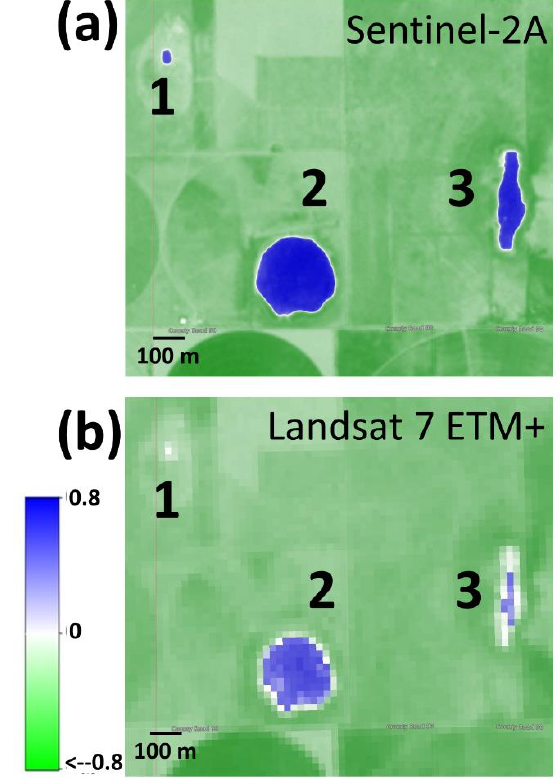
Figure 2. ( a ). Sentinel-2A imagery of the Normalized Difference Water Index (NDWI) for the location denoted with a yellow dot in Figure 1 on 22 September 2021, and ( b ) Landsat 7 ETM+ NDWI imagery from the same location on 19 September 2021. Blue areas represent water, while green areas indicate non-water areas. The 3 playas referenced in the text are indicated by the numbers 1 – 3. NDWI is processed by Sentinel Hub. The imagery contains modified European Space Agency Copernicus Sentinel data processed by Sentinel Hub, and Landsat 7 images are courtesy of the U.S. Geological Survey, processed by Sentinel Hub.